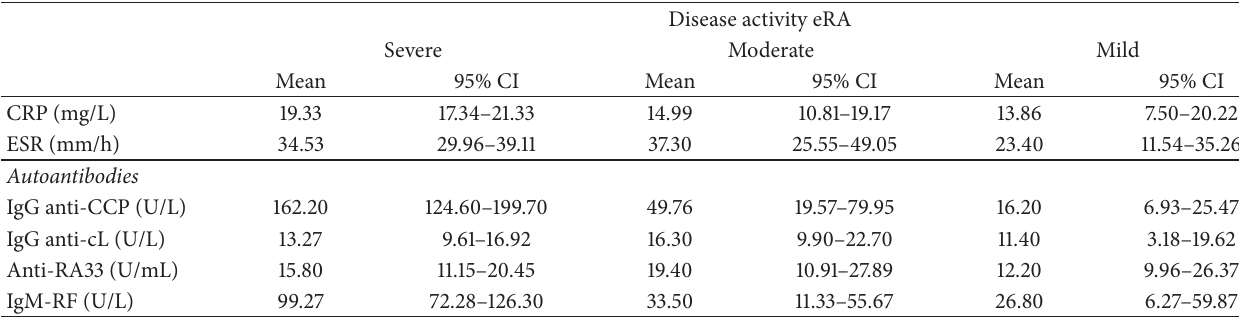
Table 2: CRP, ESR, and autoantibodies (IgG anti-CCP, IgG anti-cL, anti-RA33, and IgM-RF) concentrations in serum of patients with eRA and in the control group.